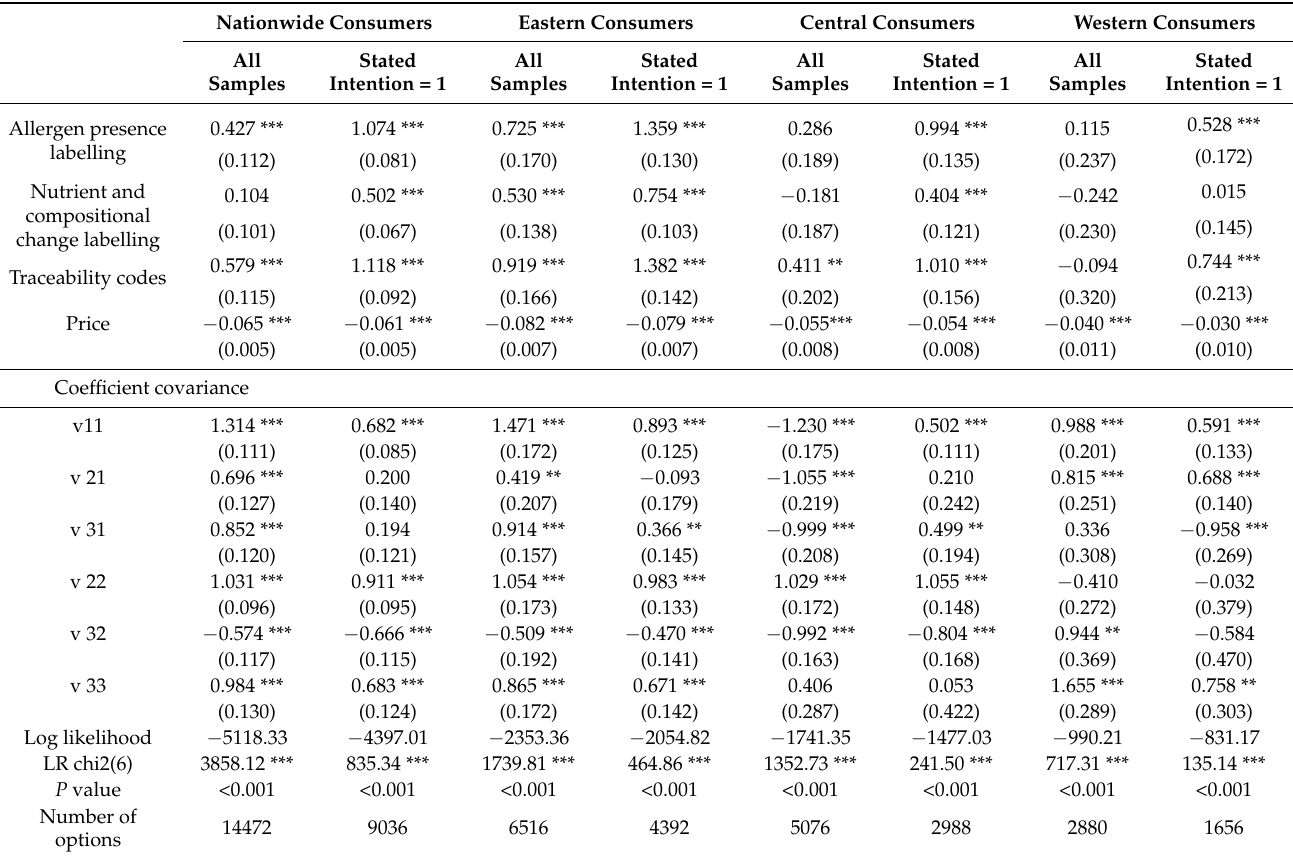
Table 4. Estimation results of the mixed logit